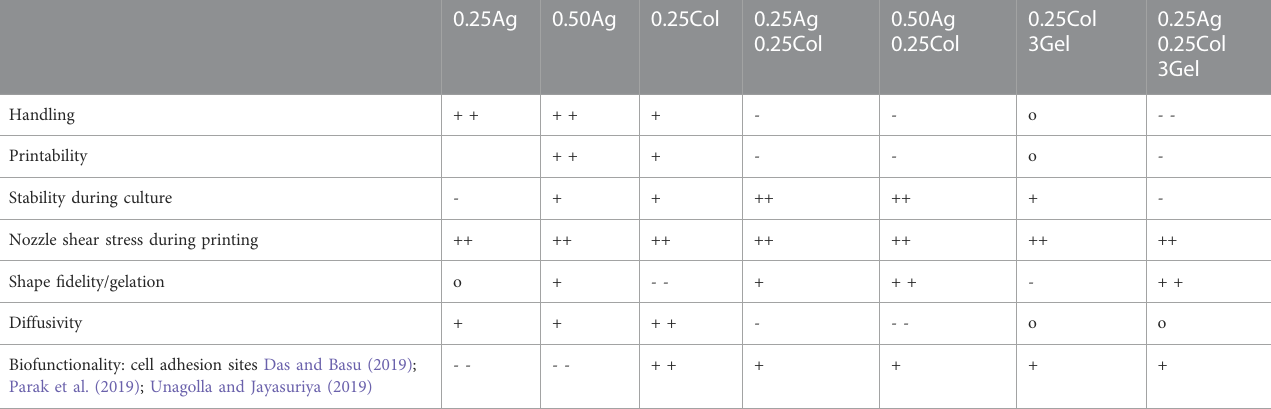
TABLE 1 Summary of material properties as tested in this work. Qualitative ratings as a comparison between materials are given with ++ (very good), + (good), o (neutral), - (poor) and - - (very